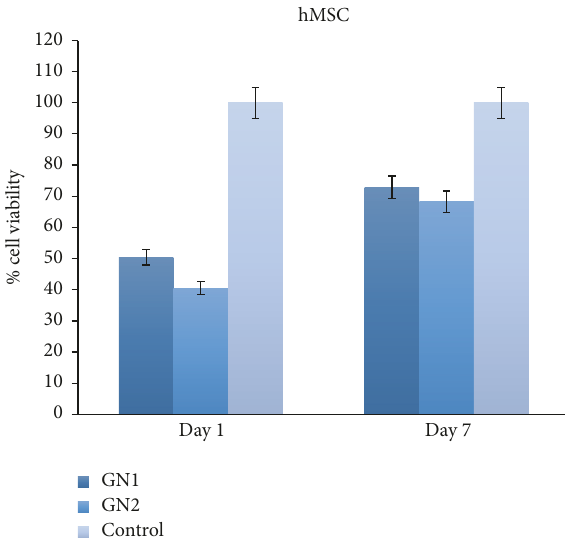
Figure 7: Cell proliferation assays by Alamar Blue on hMSC cells grown in the presence of GN1 and GN2 CS (at 1 and 7 days of culture). Data are reported as percent viability ( ± SEM) with respect to control and derive from the average of 6 replicate values ( 𝑛 = 6